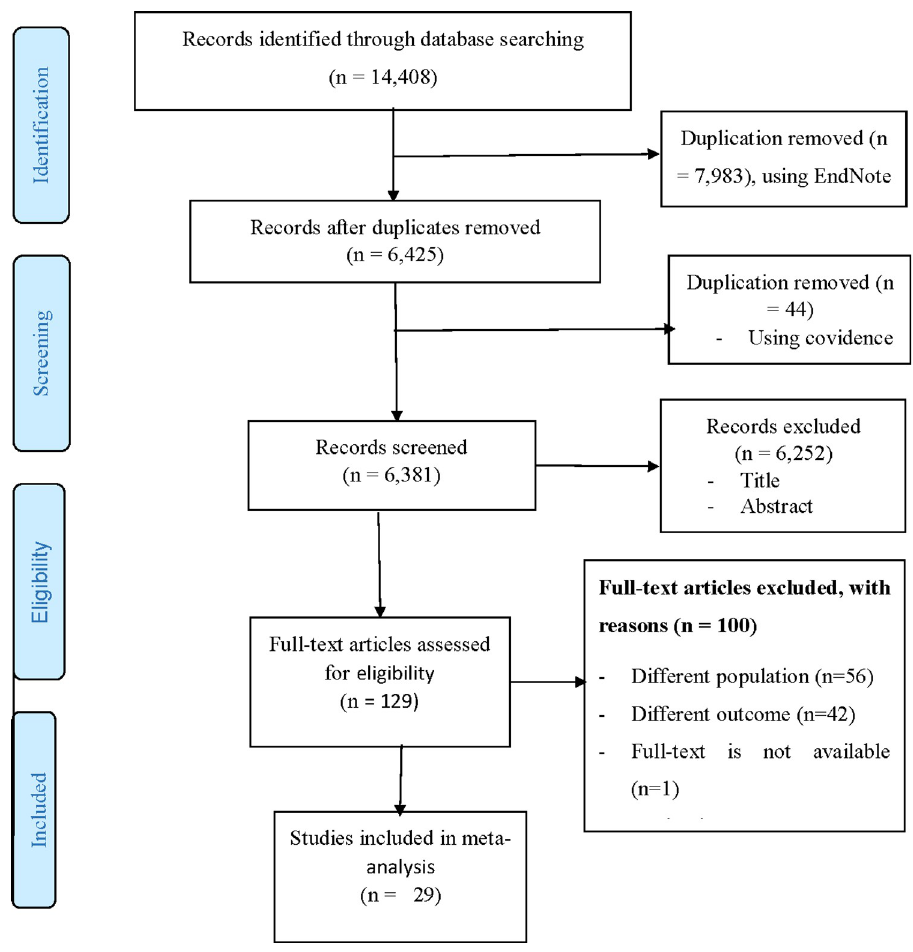
Fig 1. PRISMA flow